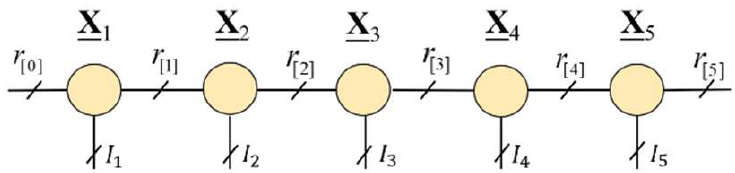
Figure 2. Visualization of a 5-order tensor train decomposition in graphical notations.